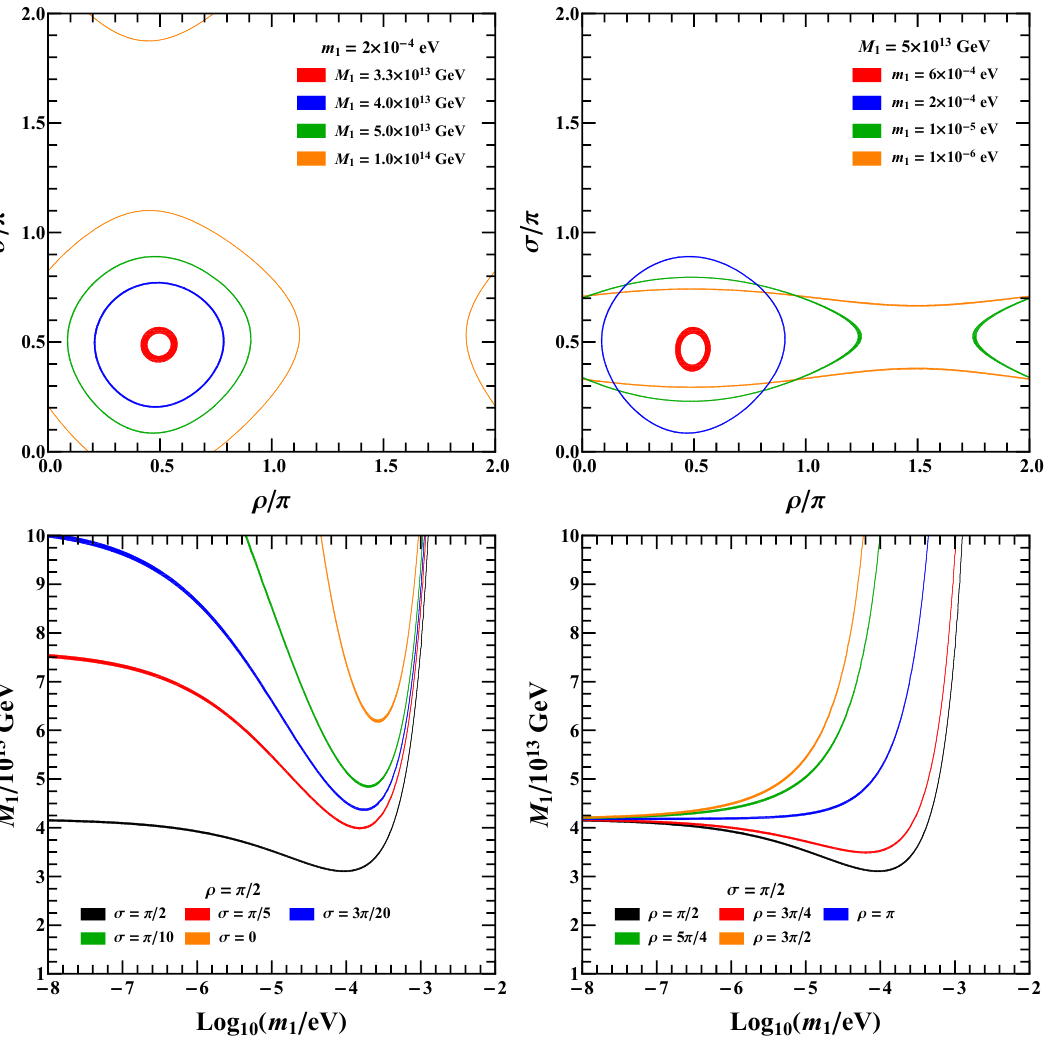
Figure 2 . A viable un(cid:13)avored leptogenesis scenario in the normal neutrino mass ordering case: the parameter space of (cid:26) and (cid:27) (upper panels) with some given values of m parameter space of m and M (lower panels) with some given values of (cid:26) and (cid:27) . 1 1